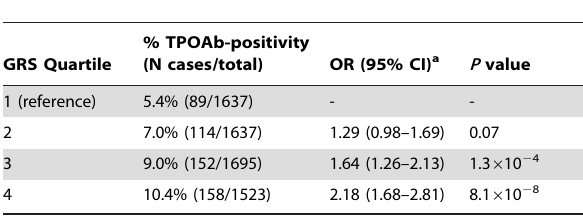
% TPOAb-positivity GRS Quartile (N cases/total) OR (95% CI) a P